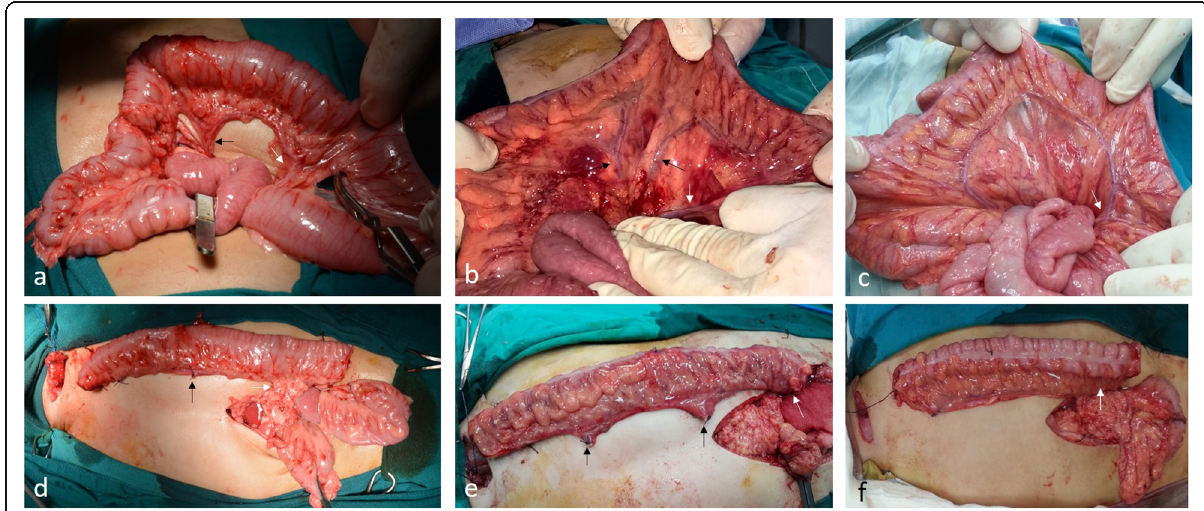
Fig. 2 Anatomical variations of the middle colic vessels. Upper row: the transverse colon in three different cases demonstrating a single, double, and absent middle colic vessel in a , b , and c , respectively. Lower row ( d , e , and f ): fashioning of transverse colonic flaps based on left colic vessels after ligation of middle colic vessels for the same three cases, respectively. Note: black arrows point to middle colic vessels, while the white arrows point to left colic vessels (flap